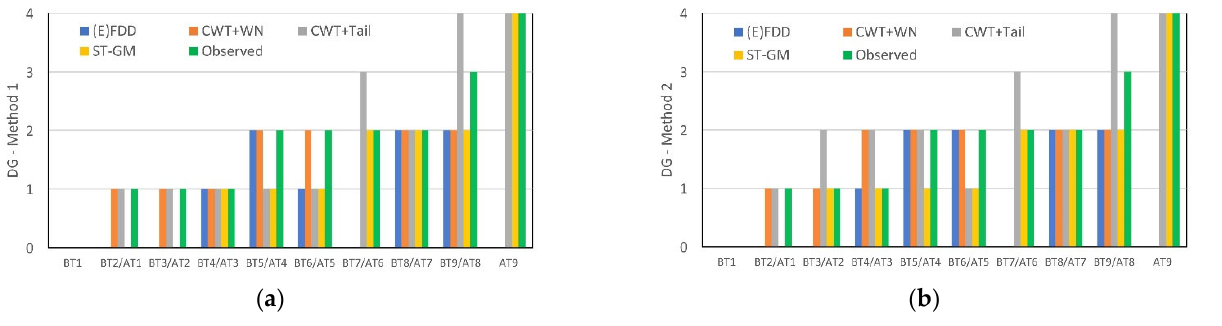
Figure 15. Damage estimations based on T i /T 0 proxy: ( a ) Empirical method through Figure 4 and ( b ) analytical method through Equation (15).